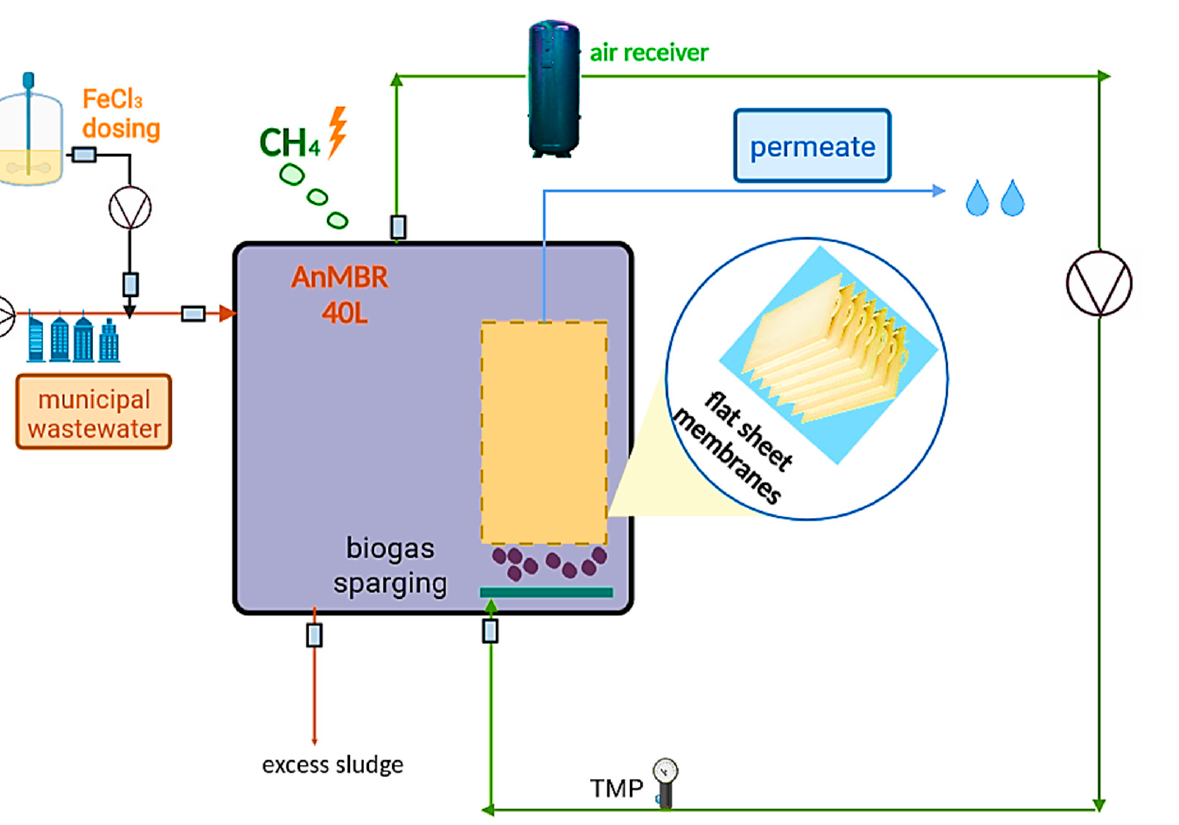
Table 3. AnMBR membrane characteristics.